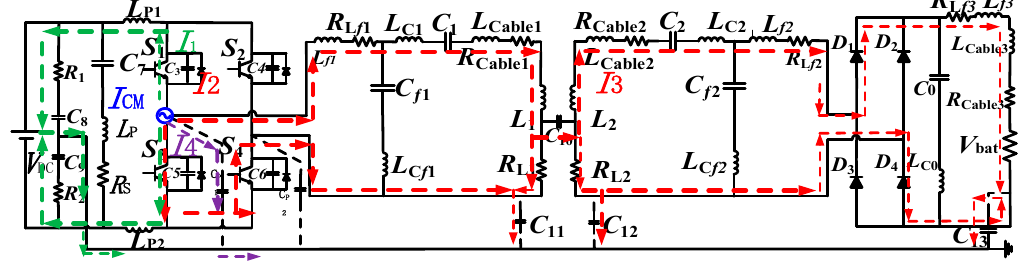
Figure 14. Analysis for CM interference: EMI current path.